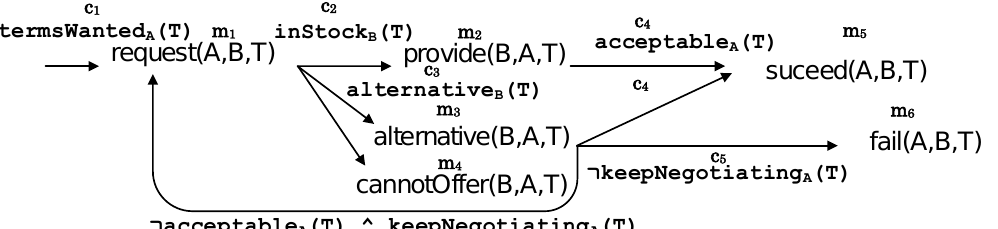
Figure 1. A negotiation protocol model where an initiator A asks for a product with some terms T from a provider B . B replies based on the availability of an item with the requested terms. When T cannot be satisfied by B , A and B can negotiate new terms for the product. Several predicates representing participants’ mental states are evaluated during this negotiation: keepNegotiating , acceptable , and alternative . Subscript A or B in link labels represent the agent that has to evaluate the predicate. Additional (redundant) shorthand notation c i / m j is introduced indicating different constraints and messages,